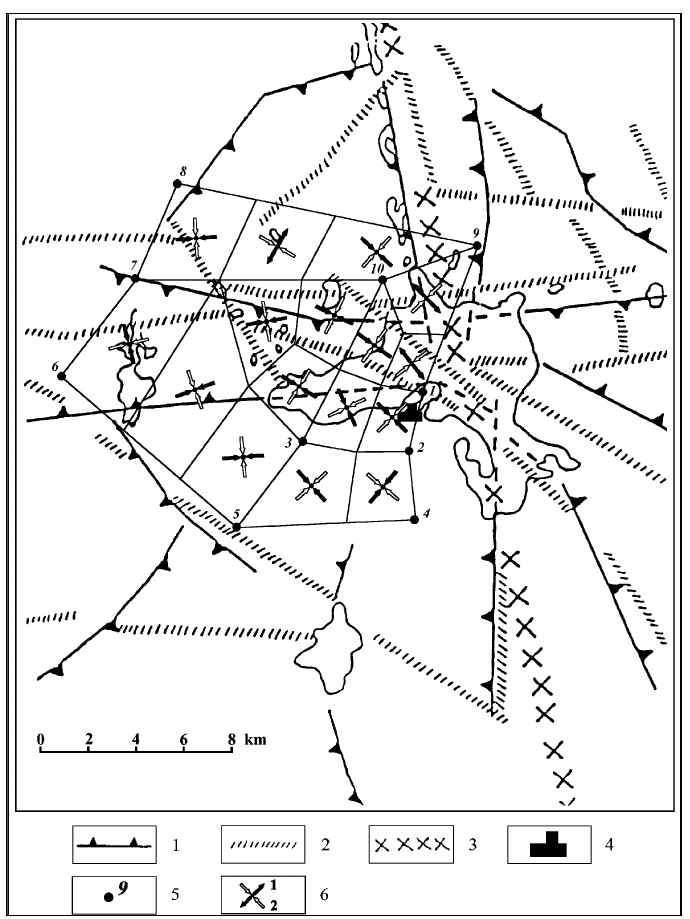
Fig 3. Directions of growths of the principal tectonic Earth crust stresses. Tectonic breaks (according to I. Juknelis, V. Marcinkevi č ius, I. Šeštokas and A. Šliaupa) discovered by: 1 – seismic survey, 2 – aeromagnetic survey, 3 – morphostructural analysis; 4 – Ignalina nuclear power plant, 5 – GPS point, 6 – the principal stresses (1 – maximum growth of the principal stress, 2 – minimum growth of the principal